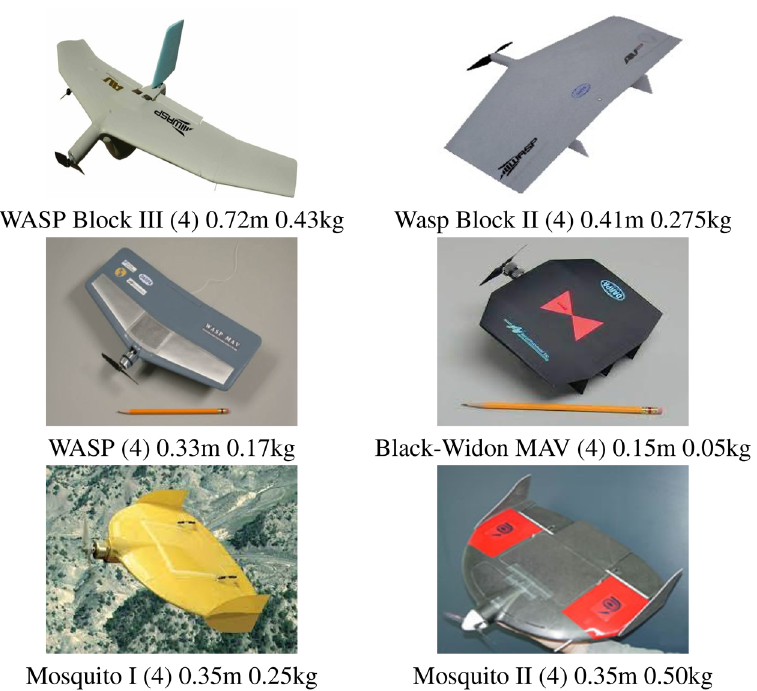
Figure 3. Main fixed wing that we consider in class (4) in the current work, from miniature to micro UAV (MAV)